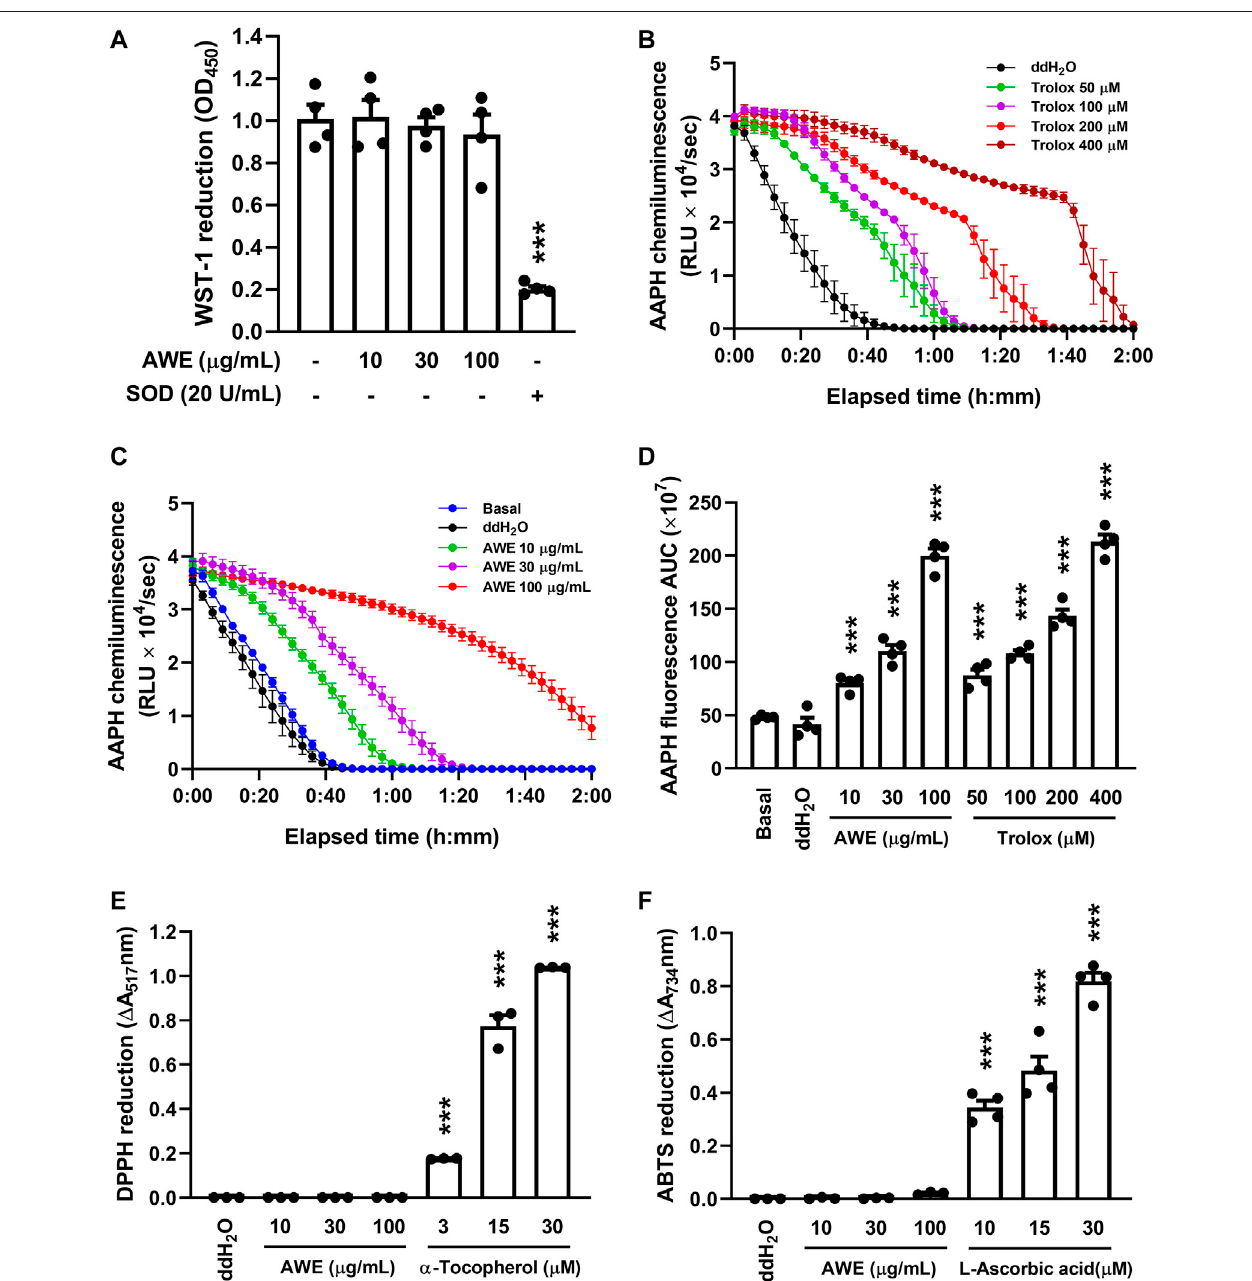
FIGURE 4 | AWE has a signi fi cant ROS scavenging effect but neither superoxide anion nor nitrogen-centered radicals. (A) 1 mM CaCl 2 in HBSS and xanthine oxidase were incubated with ddH 2 O (as the control). AWE (10, 30, and 100 μ g/ml) was added for 3 min and then xanthine (0.1 mM) for another 10 min. Reduction of WST-1 by superoxide anion was measured spectrophotometrically at 450 nm. Superoxide dismutase (SOD) 20 U/ml was used as the positive control. Fluorescein decay curve induced by AAPH and cleared by (B) Trolox and (C) AWE in different concentrations. (D) The area under the curve of AWE and Trolox. (E) DPPH (100 μ M in 99% EtOH) was incubated with ddH 2 O (as the control), AWE (10, 30, and 100 μ g/ml) or α -tocopherol (3, 15, and 30 μ M). The reduction of DPPH was measured spectrophotometrically at 517 nm. (F) ABTS (7 mM in ddH 2 O) was incubated with ddH 2 O (as the control), AWE (10, 30, and 100 μ g/ml) or L-ascorbic acid (10, 15, and 30 μ M). The reduction ofABTSwasmeasured spectrophotometrically at 734 nm. Data are expressed as the mean ± S.E.M. ( n (cid:2) 3 or 4). Statistical analysis was conducted using the one-way analysis of variance (ANOVA), followed by Tukey ’ s multiple comparison test if there were statistical differences in the results of ANOVA. Adjusted p -values of Tukey ’ s multiple comparison tests were de fi ned as *** p < 0.001 compared with ddH 2 O alone.